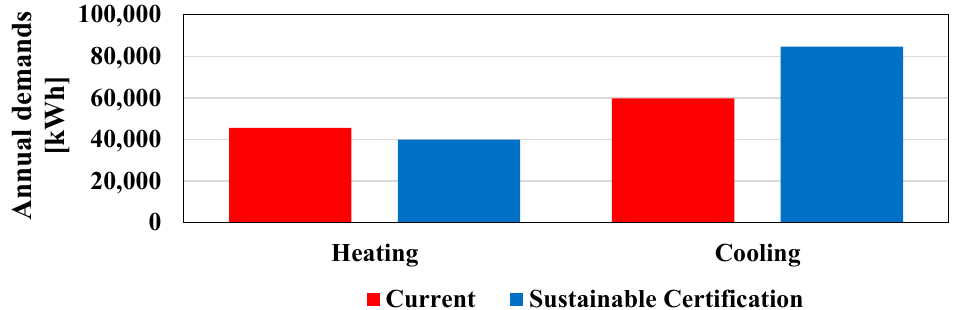
Figure 15. Heating and cooling annual energy demands for the building. The energy demands correspond to the current building and the building subjected to the retrofit intervention for sustainable building.